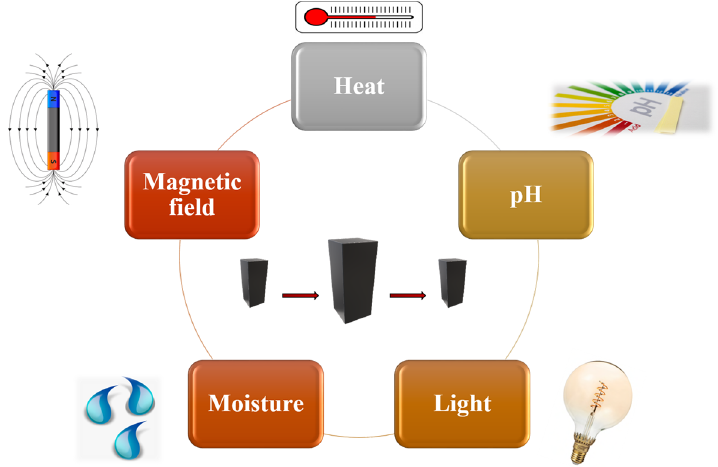
Figure 1. Stimuli-responsive shape-memory polymers.